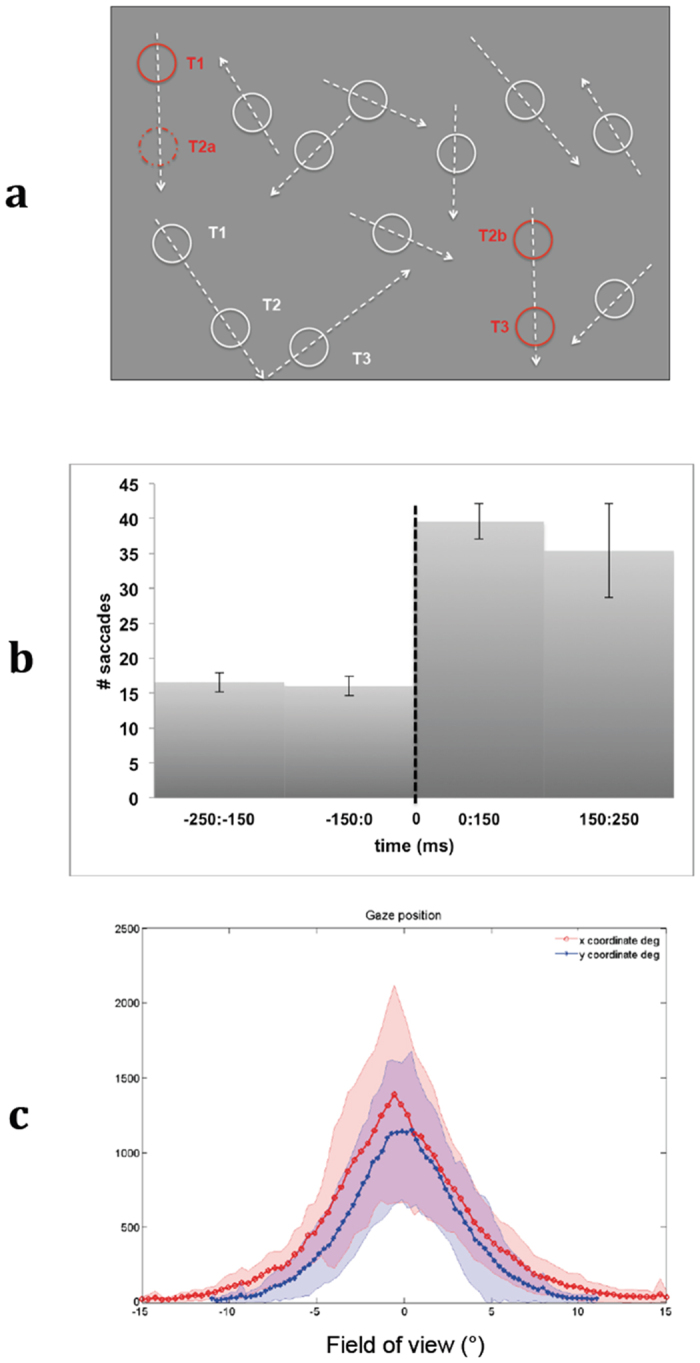
(a) Visual scenes consisted of multiple identical non-filled white circles (n = 10) moving along linear trajectories on a gray background and bouncing off display boundaries. Participants were required to detect a visual item (depicted in red for illustrative purpose only) moving along a predictable trajectory that from time to time was spatially displaced with variable changes in amplitude and orientation (inter-displacement time ranged between 2000 and 4000 ms). A 0° amplitude corresponded to a displacement in the same trajectory of the moving item. The randomly selected displaced item (e.g. red dotted circle at time T2a) continued a linear motion (T2b - > T3) with the same direction and speed prior to displacement (T1 - > T2a) but in a different position. (b) Average number of express and regular saccades ( ± SD) towards visual target within 250 ms time windows before and after displacement (time = 0). (c) Distribution of gaze position (number of times over each display position) during our visual detection task. The red and blue curves represents how many times ( ± SD) the gaze was oriented towards each x and y coordinate respectively. Participants reported having mainly focused on the central part of the scene when debriefed; sometimes they referred being captured by moving stimuli and having performed singular smooth pursuit eye movements but they reported not having tracked multiple moving items.